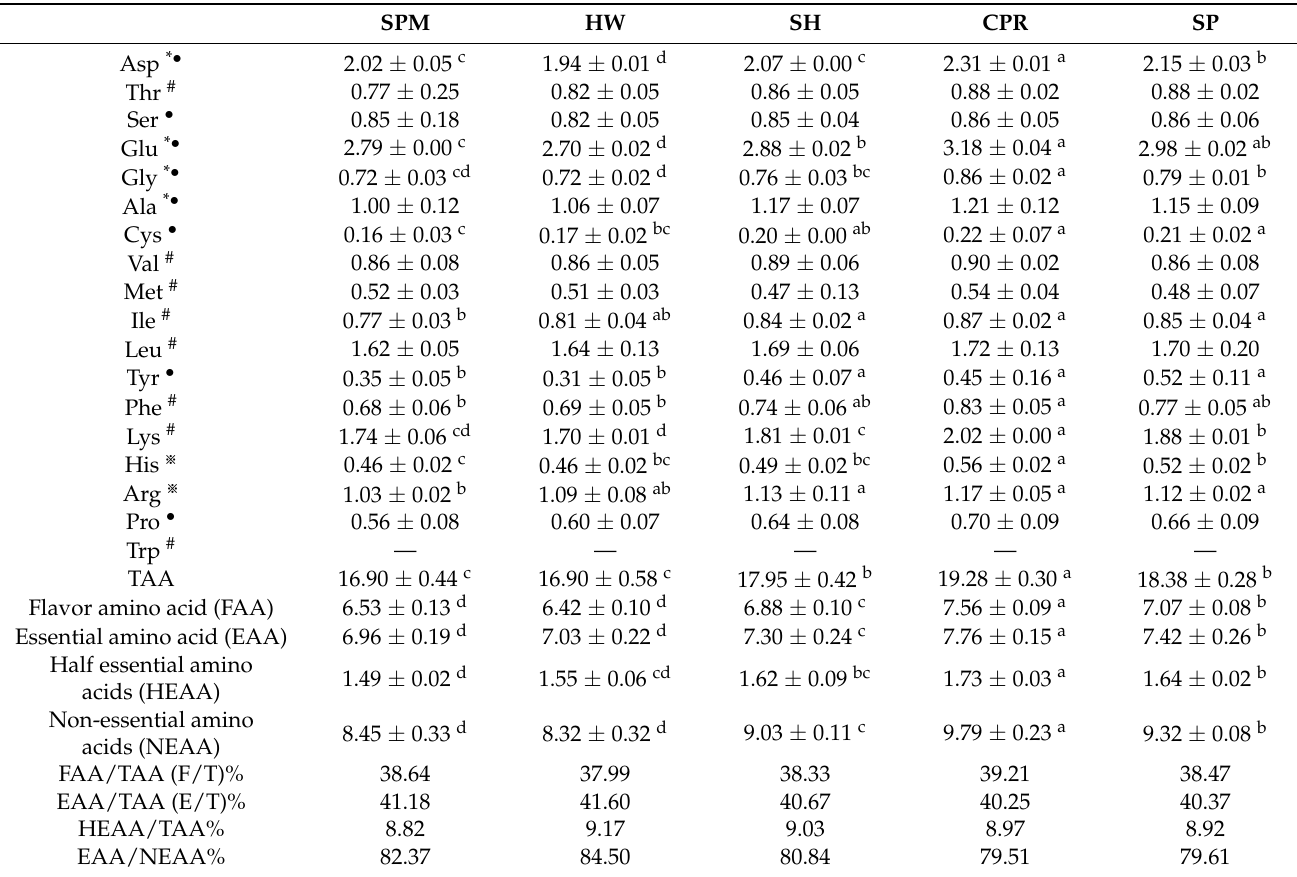
Table 6. Amino acid content in five species of common carp (fresh flesh weight, g/100 g). SPM HW SH CPR